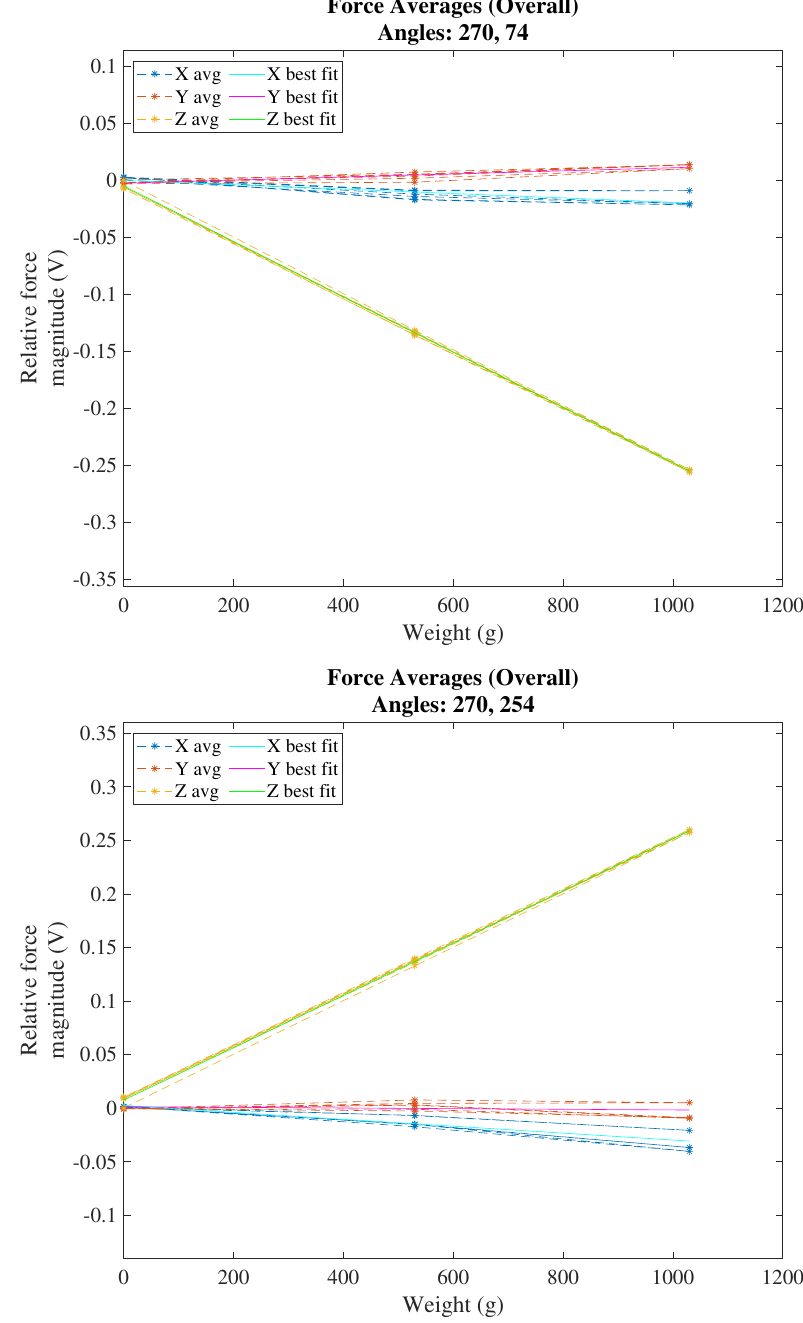
Figure A5. Voltage response to 3D calibration loading in different